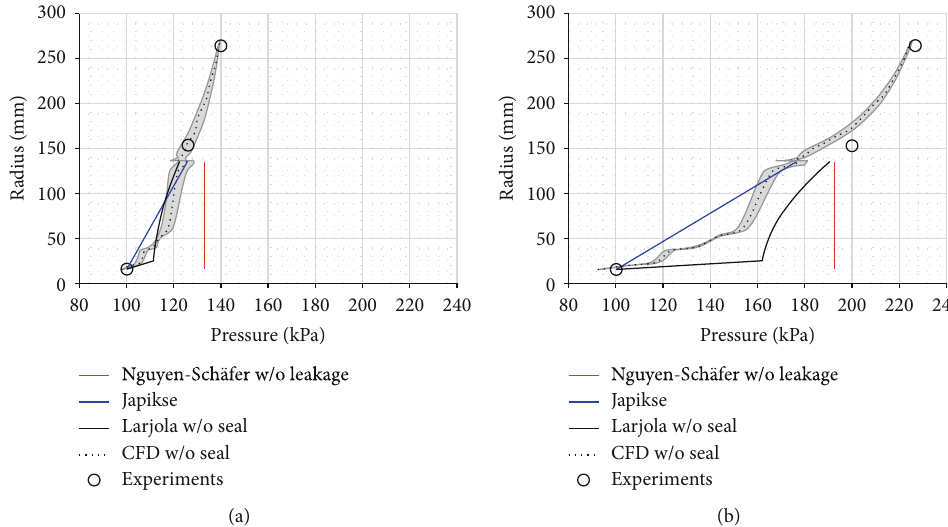
Figure 11: Pressure distribution on the back disk without labyrinth seal. Solid lines: three methods, dotted line: CFD, gray area: discretization error, and circles: experiments. (a) Point 1. (b) Point 9. Points 2 – 8 fall within these two extremes.